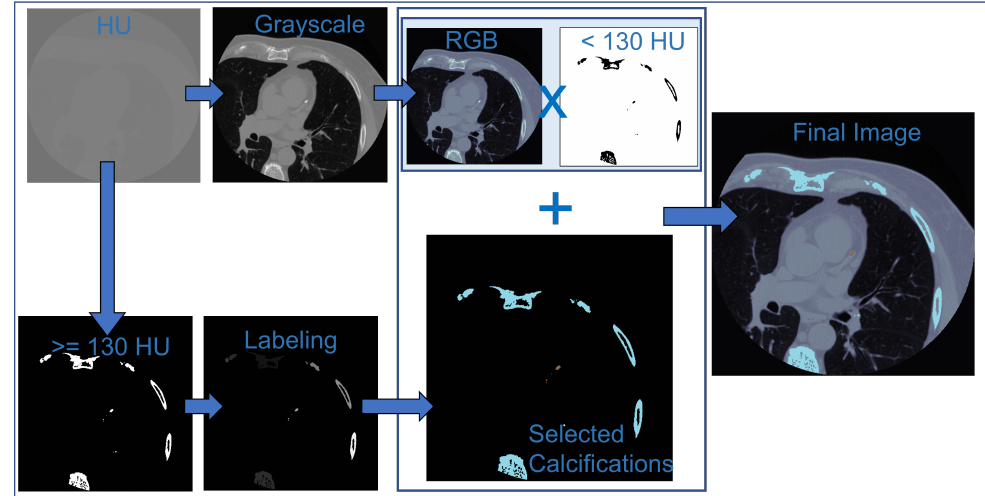
Figure 3. Digital processing of computed tomography